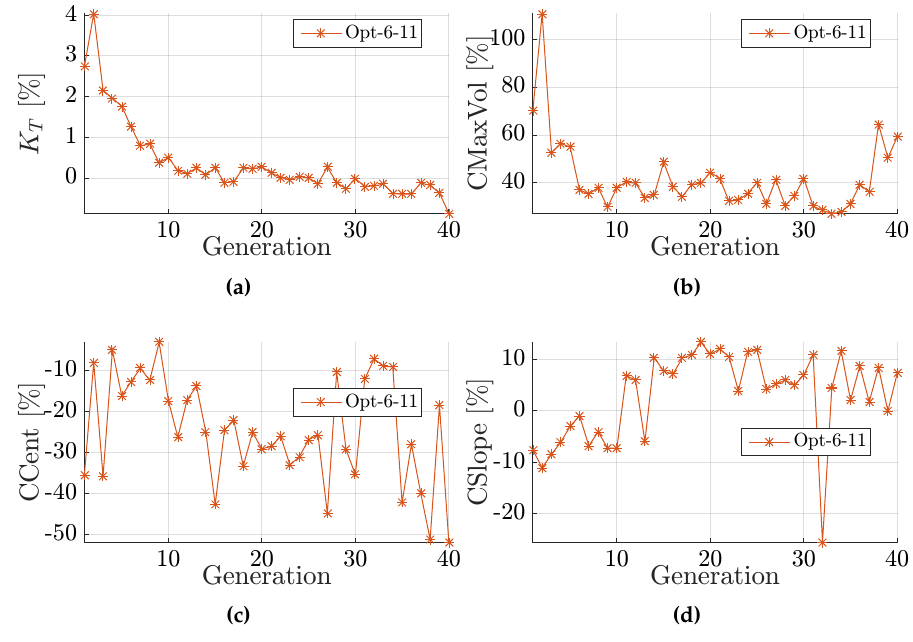
Figure 25. Development of constraints median throughout the optimisation. ( a ) K T ; ( b ) Cavity Volume; ( c ) Cavity Centroid; ( d ) Cavity Closure.